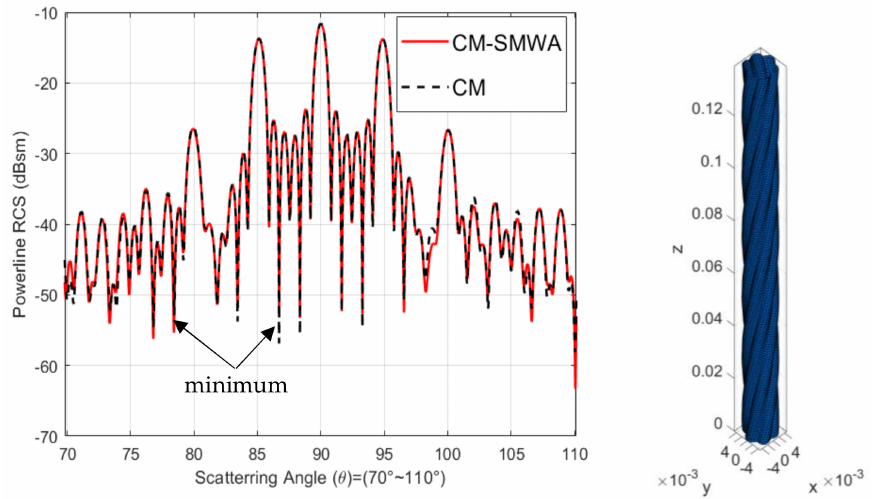
Figure 13. Simulation results of the power line RCS with the different algorithms at 76 GHz (H-H).